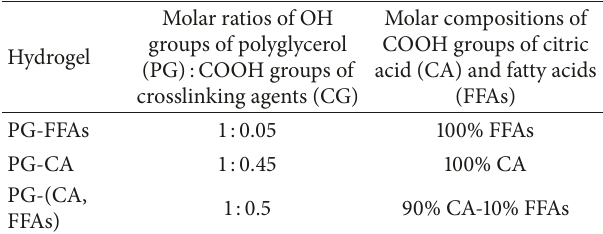
Table 2: Samples compositions used for the hydrogels synthesis.